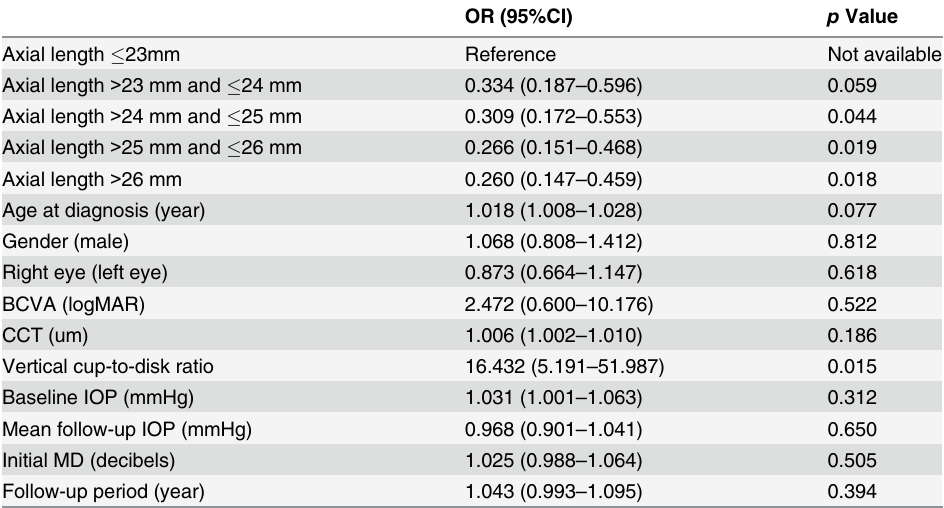
OR (95%CI) p Value